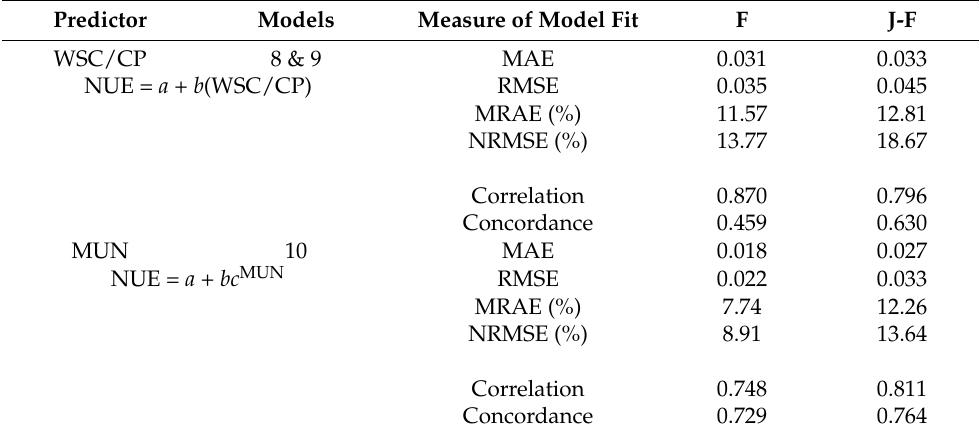
Table 7. Measures of deviation between observed and predicted values of NUE for data obtained from studies not used in model development: mean absolute error (MAE), root mean square error (RMSE), mean relative absolute error (MRAE), and normalised root mean square error (NRMSE). Relationships between observed and predicted values of NUE are illustrated using Pearson’s correlation coefficient and Lin’s concordance coefficient. Friesians N = 27; Jersey × Friesian N = 13. Model numbers refer to the equations presented in Table